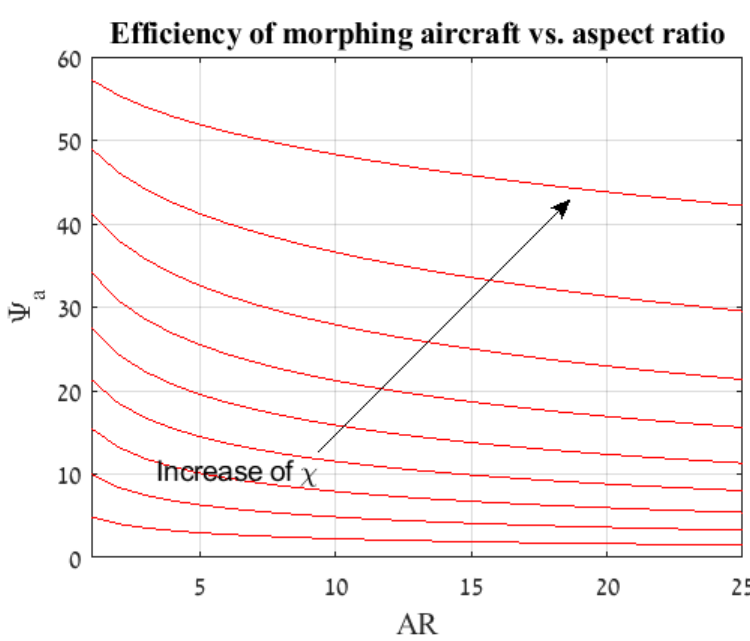
Figure 9. Morphing efficiency over standard aerobatic aircraft vs. aspect